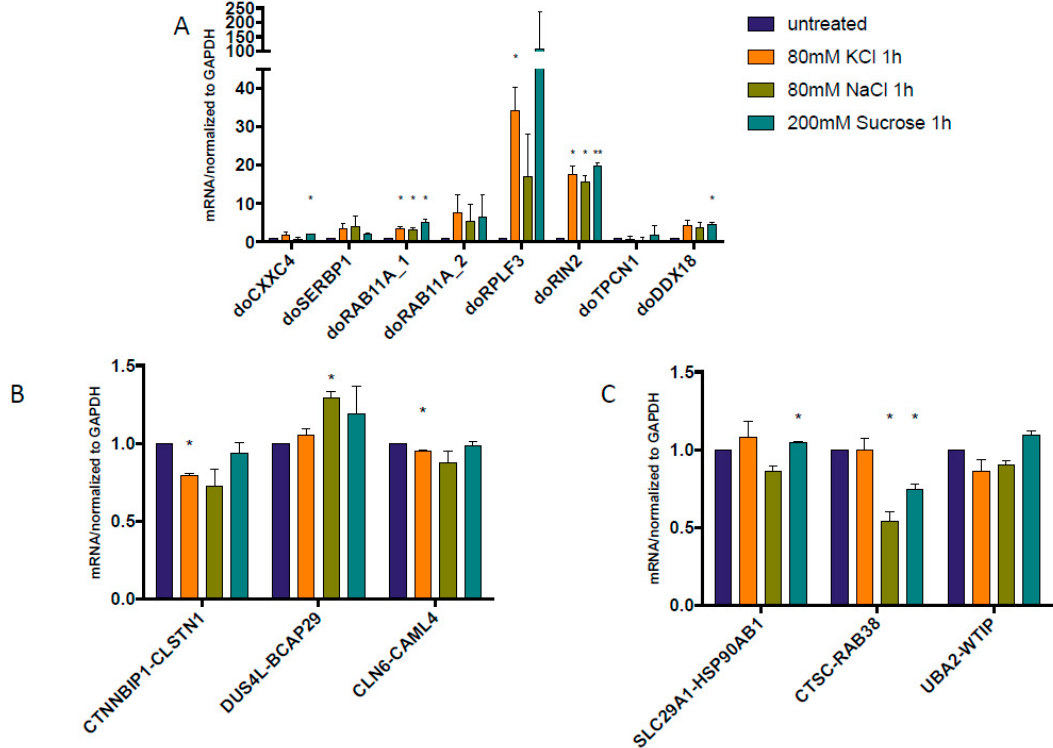
Figure 1. Quantitative reverse transcription polymerase chain reaction (qRT-PCR) measuring the levels of downstream of genes (DoGs) and cis-splicing between adjacent genes (cis-SAGe) fusions at 1 h after osmostress. RNAs were extracted from HEK293T cells treated or untreated with three osmotic stresses. ( a ) DoGs from the previous report [19] were measured, and confirmed their induction after the stress; ( b ) Three cis-SAGe fusion RNAs, CTNNBIP1-CLSTN1 , DUS4L-BCAP29 , and CLN6-CALML were measured; ( c ) Addition cis-SAGe RNAs, SLC29A1-HSP90AB1 , CTSC-RAB38 , and UBA2-WTIP , were selected based on the discovery of DoGs of their 5’ parental genes. The levels of various transcripts were normalized to that of GAPDH , and further normalized to the untreated samples. *: p < 0.05, **: p < 0.01.